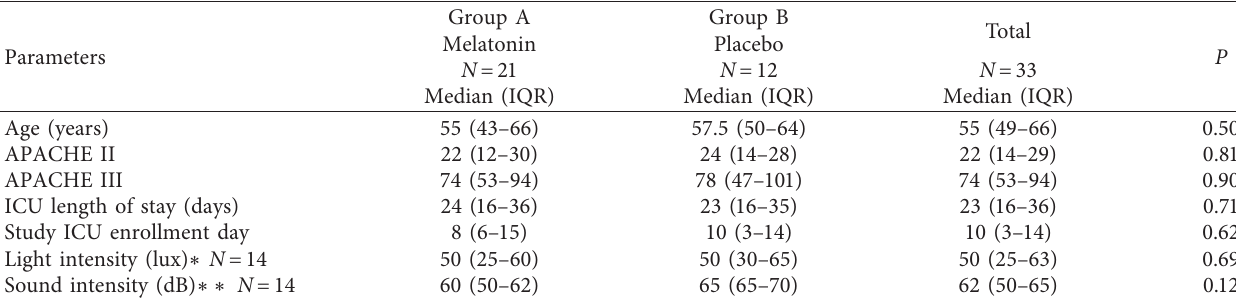
Figure 2: Consort diagram. Representation of the initially randomized but progressively missed patients. Table 2: Epidemiologic and environmental characteristics of the studied